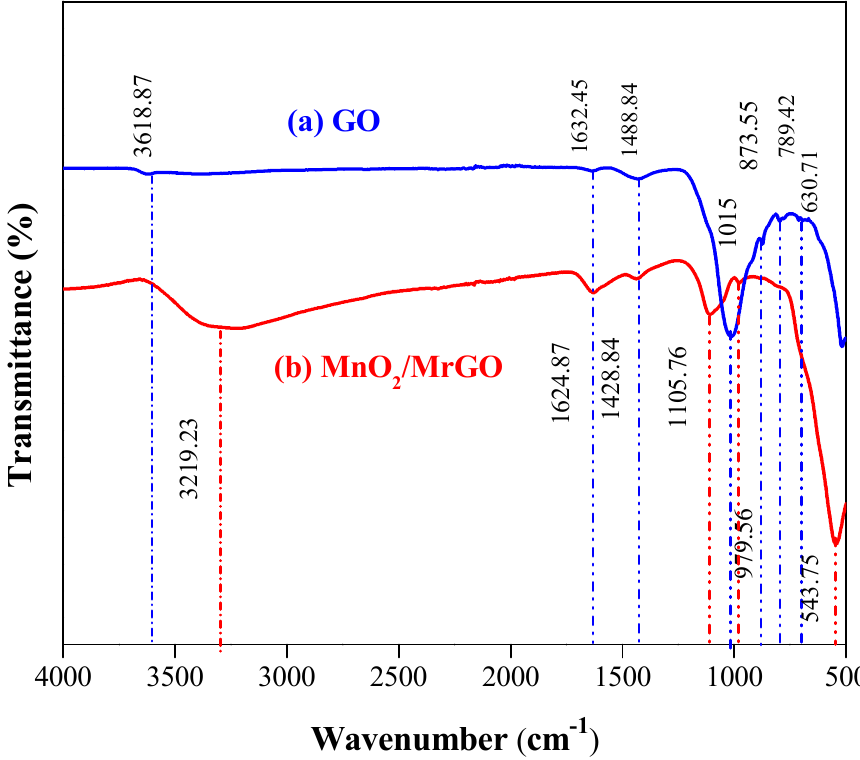
Figure 1. Fourier-transform infrared spectroscopy (FTIR) spectra of ( a ) graphene oxide (GO) and ( b ) MnO 2 /MrGO.